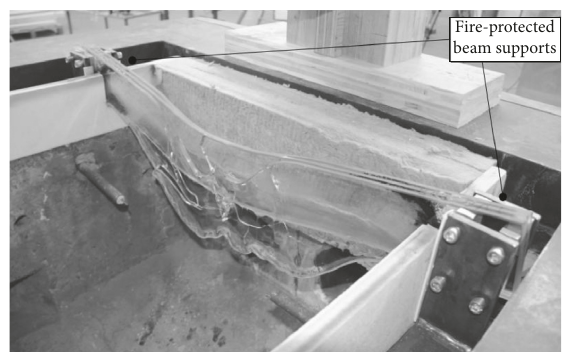
Figure 15: LG glass beams tested by Louter and Nussbaumer [77]. Typical failure